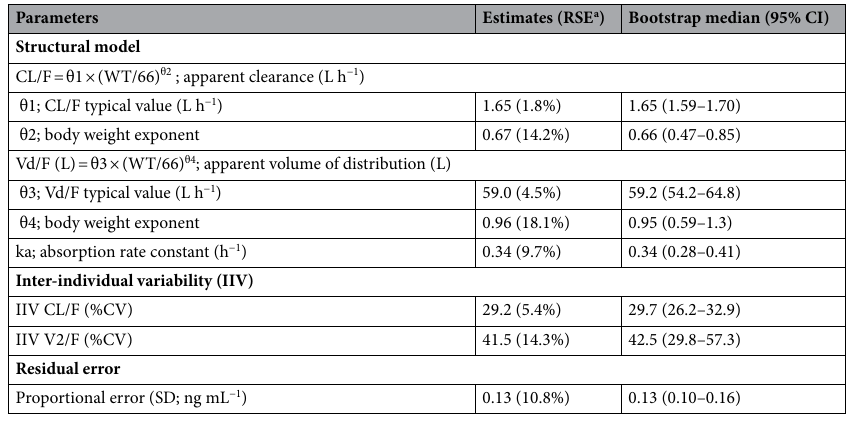
Table 2. Parameter estimates and variability for the population pharmacokinetic model of MHD. a CI: confidence interval, which was estimated by applying the final population pharmacokinetic model to 1000 resampled datasets. CV coefficient of variation, MHD monohydroxy derivative of oxcarbazepine, RSE relative standard error, SD standard deviation, WT body weight.